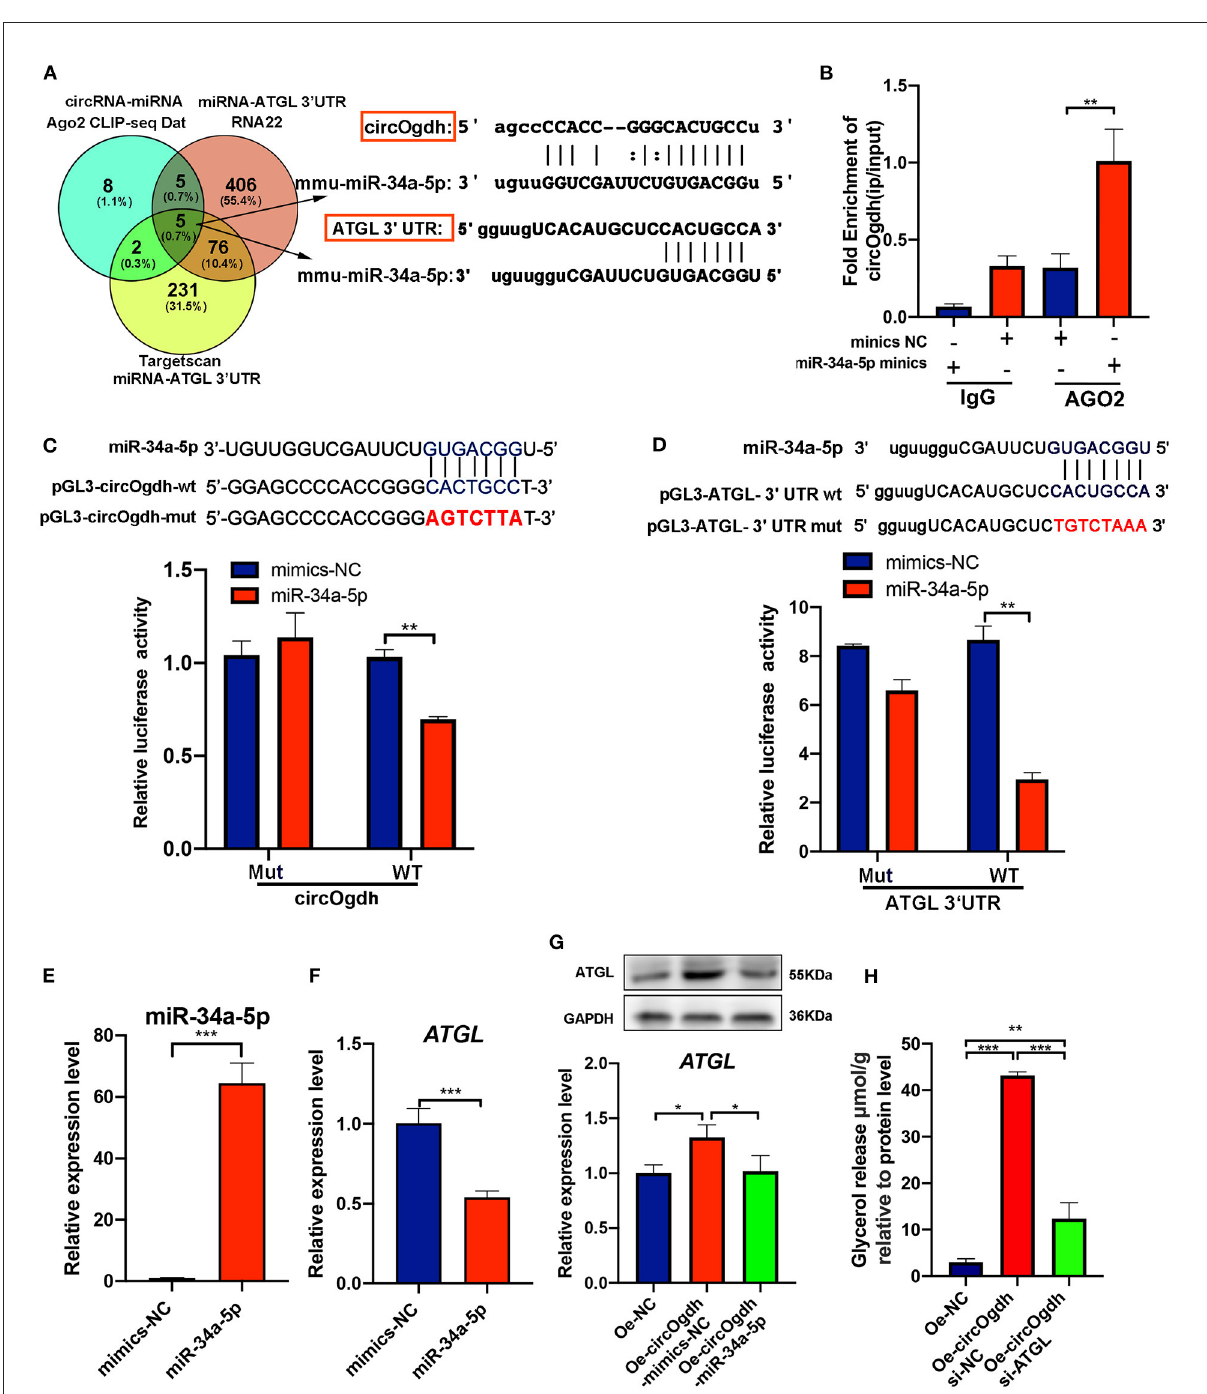
FIGURE9 CircOgdh promotes lipolysis by alleviating the miR-34a-5P-mediated inhibition of ATGL expression. (A) Ago CLIP-seq data (https://starbase. sysu.edu.cn), RNA22 (https://cm.jefferson.edu/rna22), and Targetscan (https://www.targetscan.org) were used to predict miRNAs targeting both circOgdh and Atgl . (B) RIP was performed using the AGO2 antibody in BAT cells transfected with miR-34a-5p mimics or NC mimics. CircOgdh enrichment was then detected. (C,D) Luciferase reporter activity of circOgdh and Atgl 3 ′ UTR in HEK-293T cells co-transfected with miR-34a-5p mimics or NC mimics. (E,F) RT-qPCR analysis of miR-34a-5p and Atgl in the control and miR-34a-5p-overexpressing brown adipocytes. (G) Detection of Atgl mRNA and protein expression levels via qRT-PCR and western blot after transfection with the control, Oe-circOgdh mimic-NC, or Oe-circOgdh mimic-miR-34a-5p overexpression vector. (H) The release of glycerol content was normalized to the total amount of protein for each sample in NC, Oe-circOgdh overexpression and Oe-circOgdh si-ATGL groups under Fsk stimulation. Values in (B–H) are means ± SEM ( n ≥ 3). * P < 0.05, ** P < 0.01, *** P <